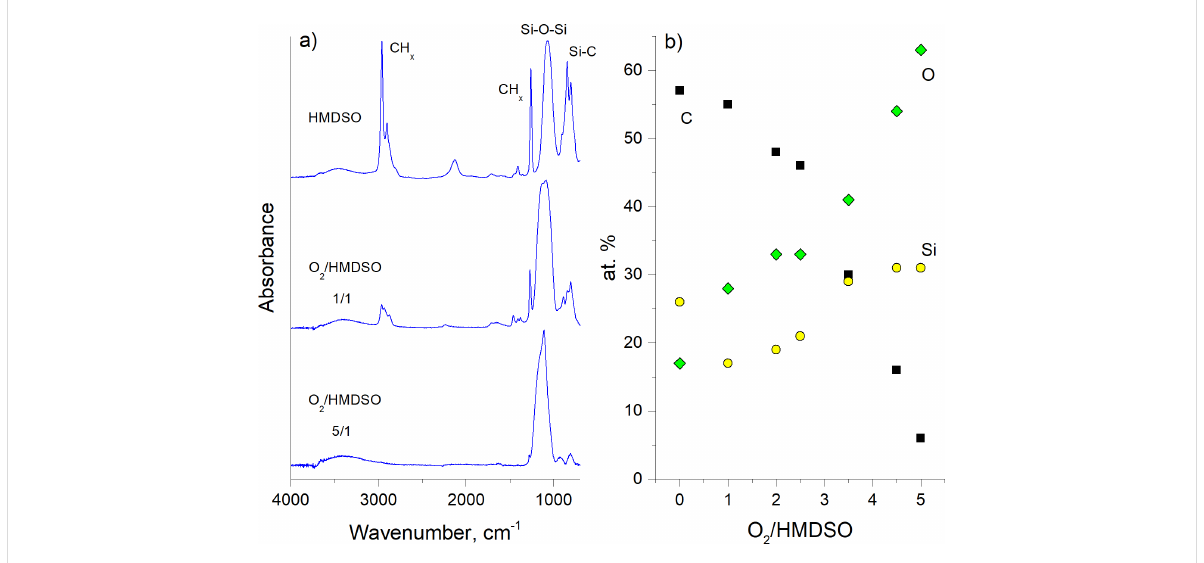
Figure 8: Chemical composition of the NPs shown in Figure 7: a) FTIR spectra b) the elemental content calculated from the XPS spectra as a func- tion of the O 2 concentration in the working gas (republished from [53] with permission of IOP Publishing Ltd.).